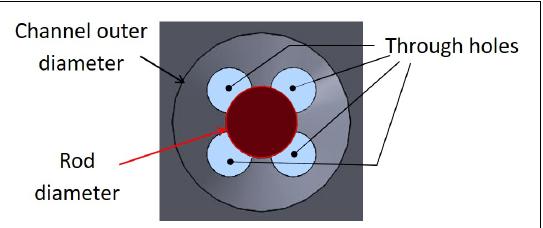
Figure 2. Example of a transition geometry with channel cross-section